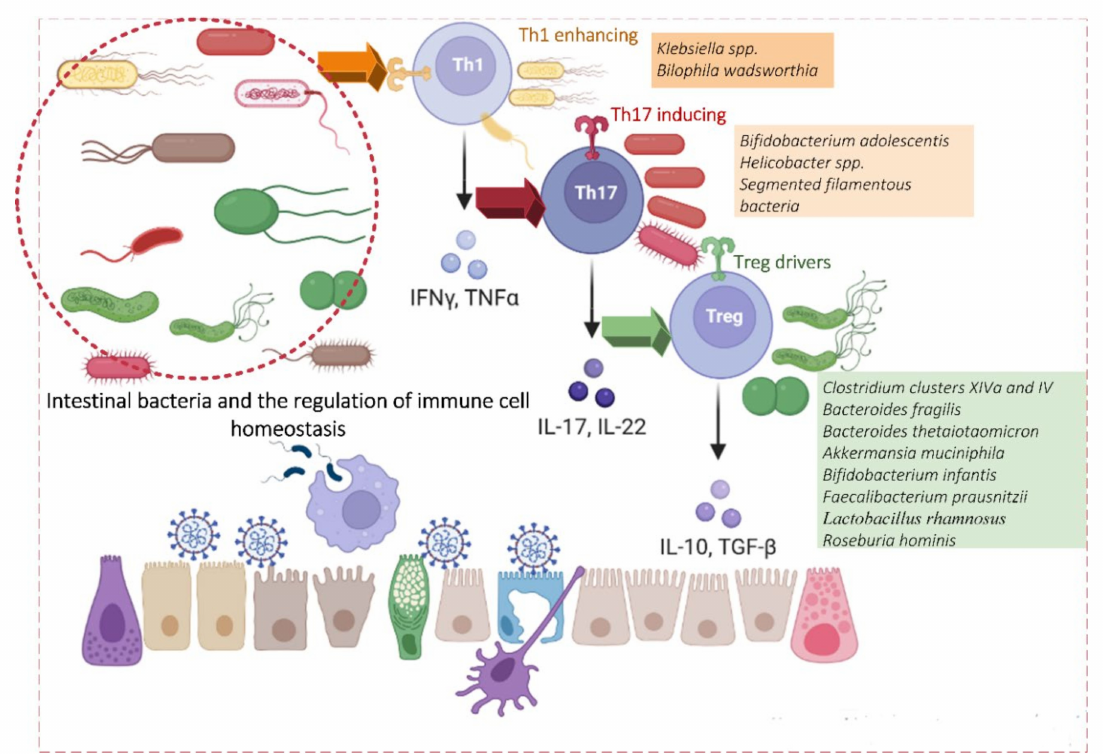
Figure 1. Intestinal bacteria and immune cell homeostasis regulation. The main bacterial inducers of intestinal CD4+ T cells are